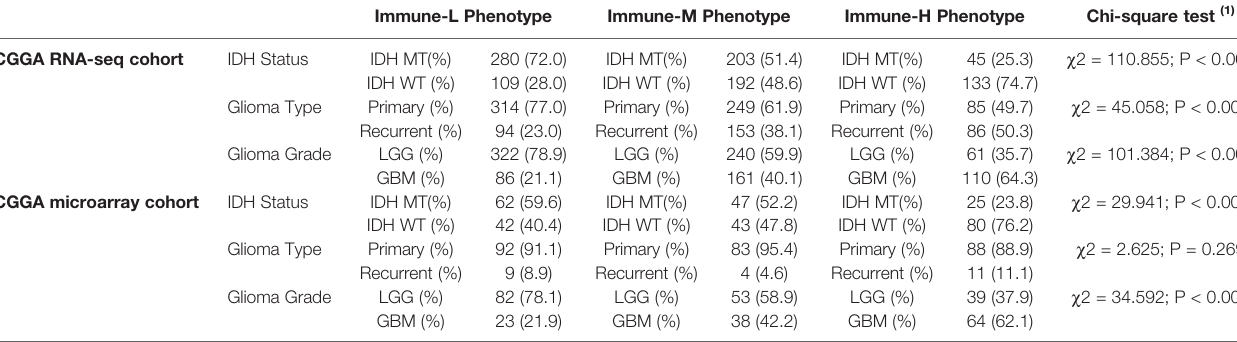
TABLE 2 | Distribution of IDH status, type and grade of glioma among immune phenotypes in CGGA